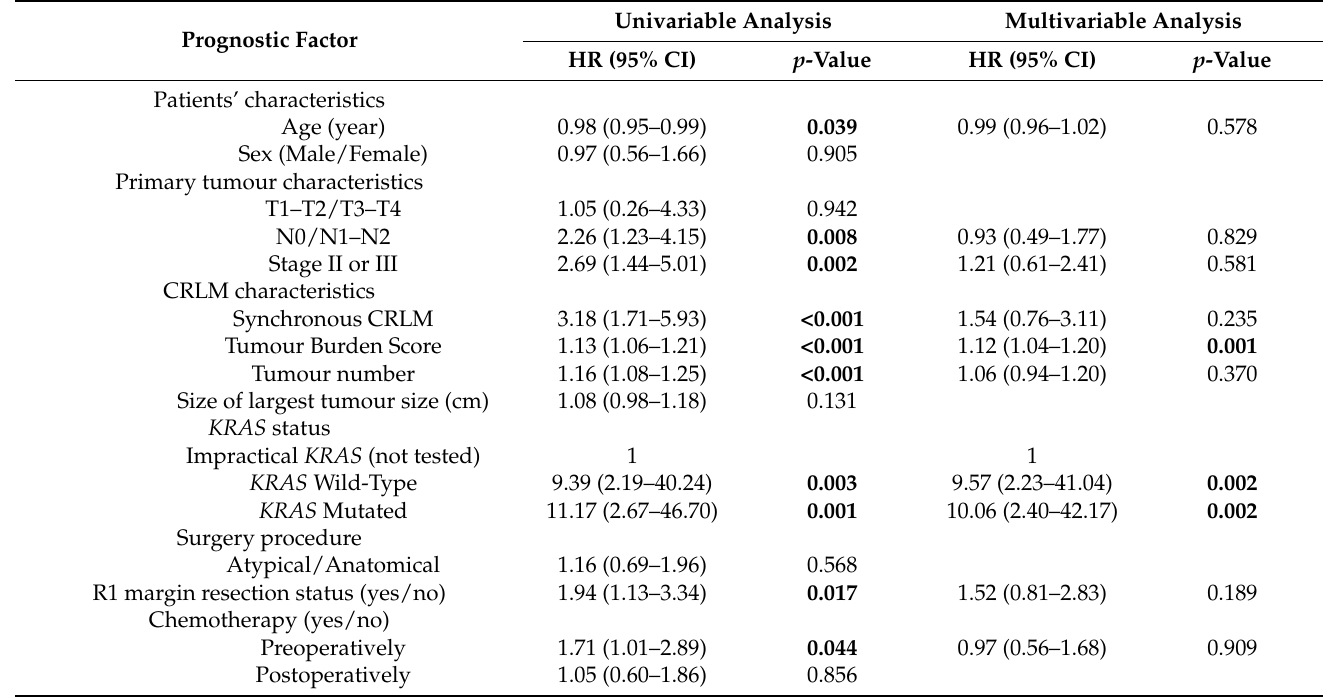
Table 2. Uni-and Multivariable Predictors of Disease-Free Survival in the Entire Cohort.